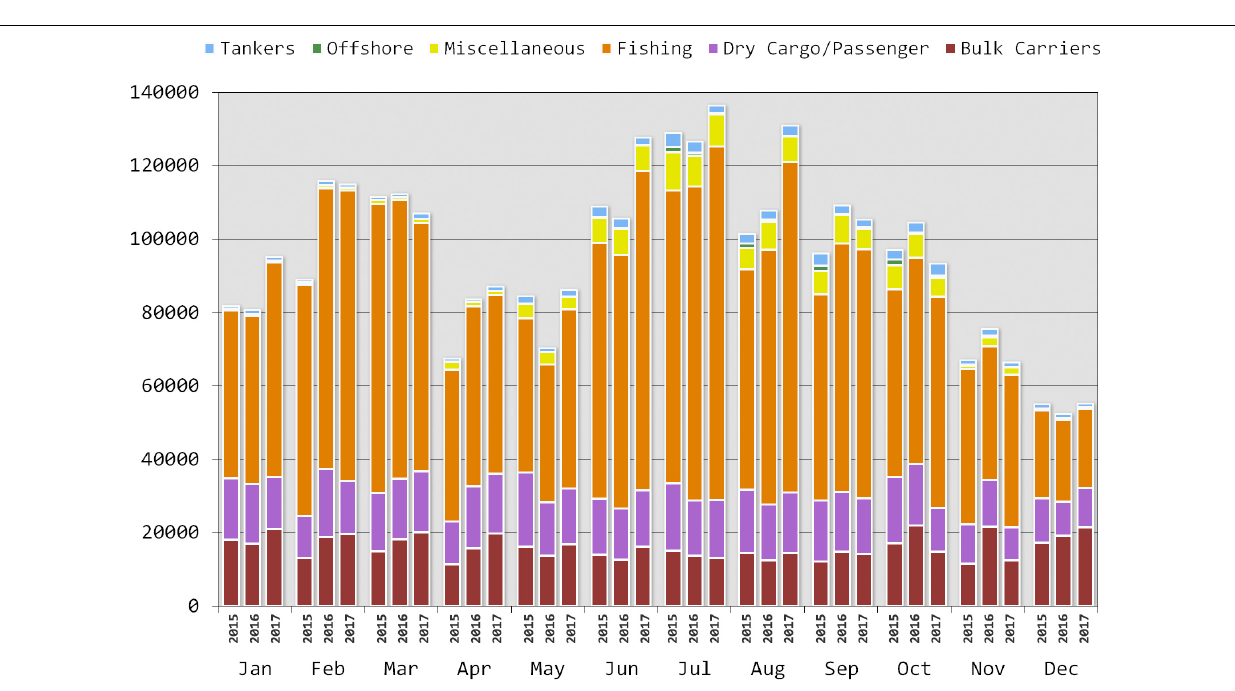
FIGURE 5 | Vessel hours of operation in the Norwegian Sea, by month and vessel class, in 2015, 2016, and 2017.